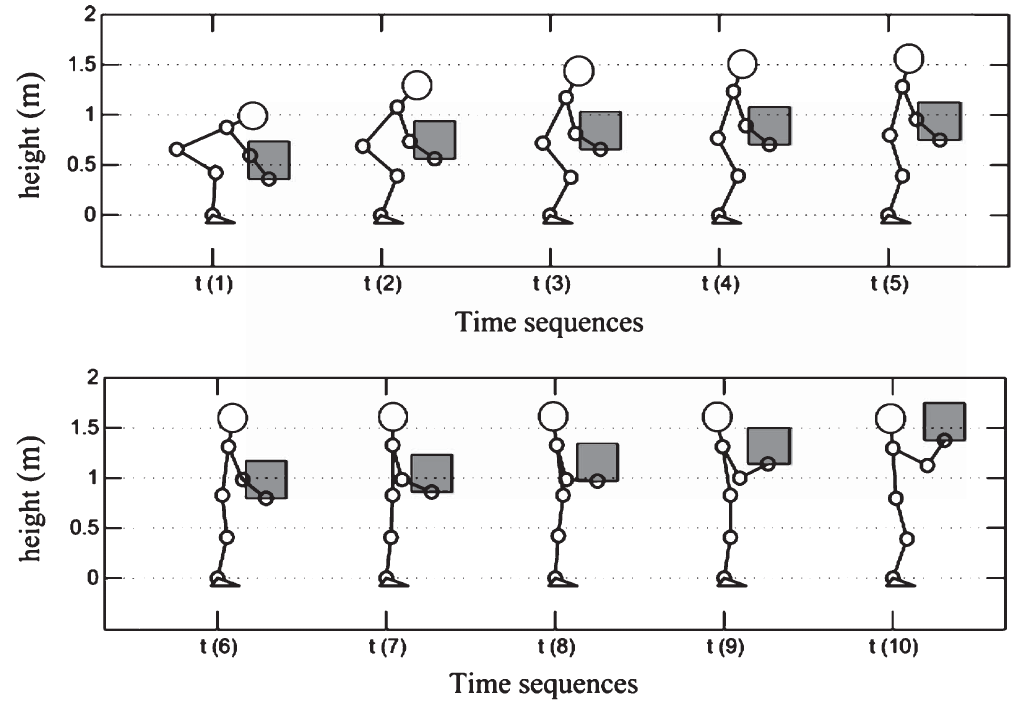
Fig. 6. The variation of human body postures during lifting task. The vertical axis shows the height in meter and the horizontal axis is time